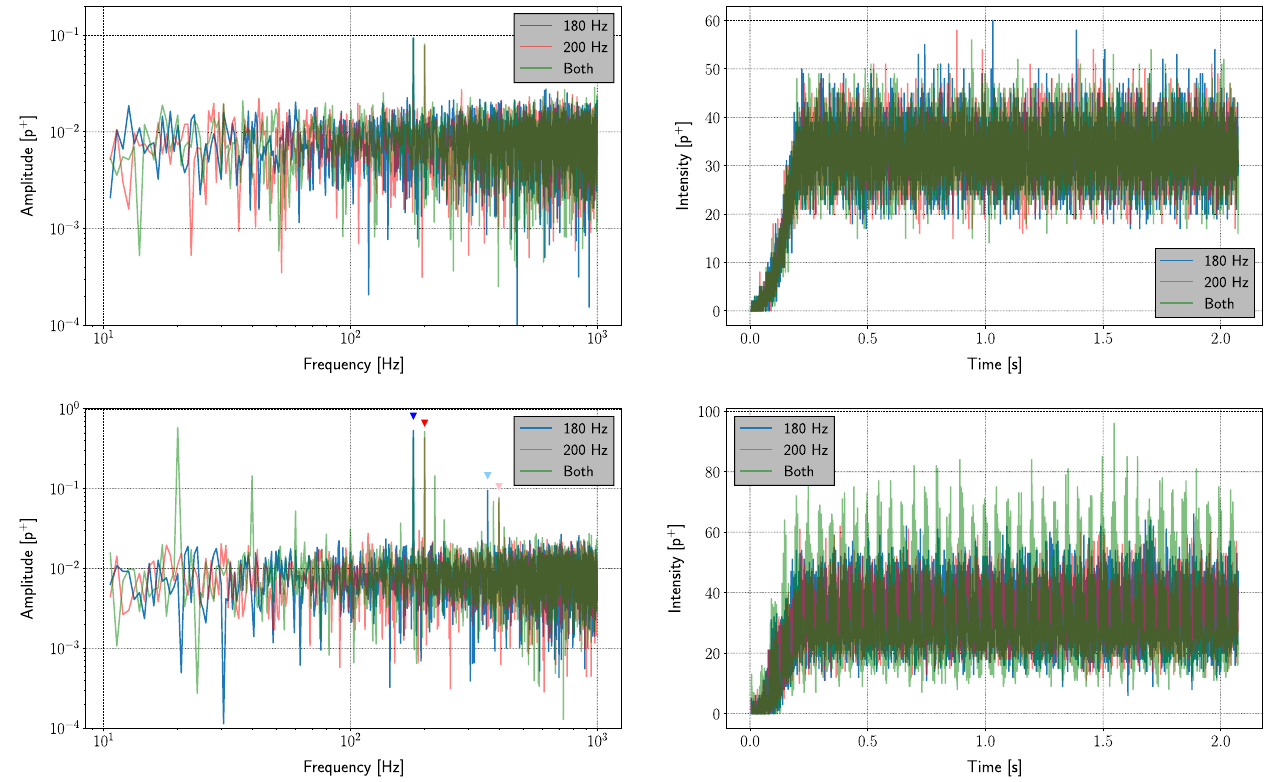
FIG. 4. Ripple signal spectra (left) and corresponding extracted spills (right) obtained by injecting 180 and 200 Hz ripple signals with equal amplitude, both separately and together. Top plots: ripple amplitudes below the linearity threshold. Bottom plots: above the linearity threshold; the single injected main frequencies and harmonics are highlighted respectively by full color and faded